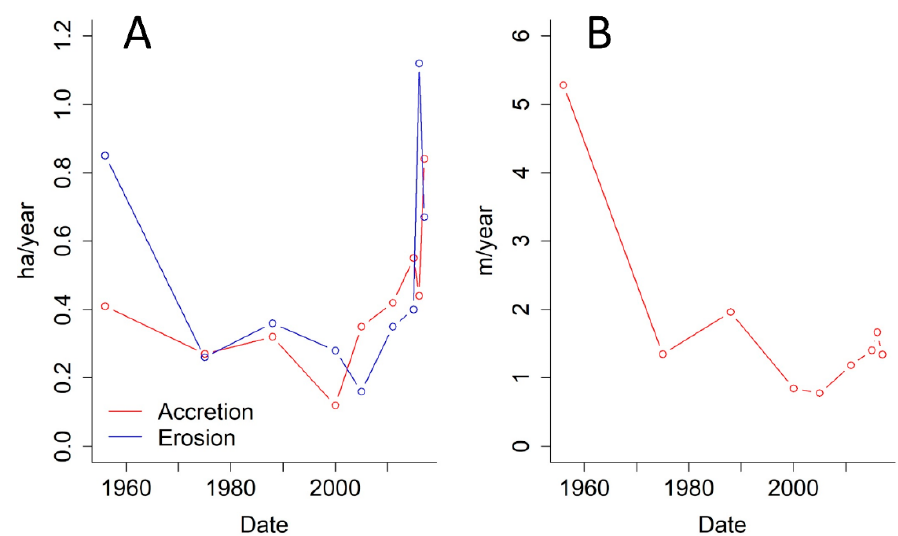
Figure 5. ( A ) Time series of normalized accretion and erosion rates in the studied period; ( B ) Time series of mean lateral channel shift rates in the studied period.